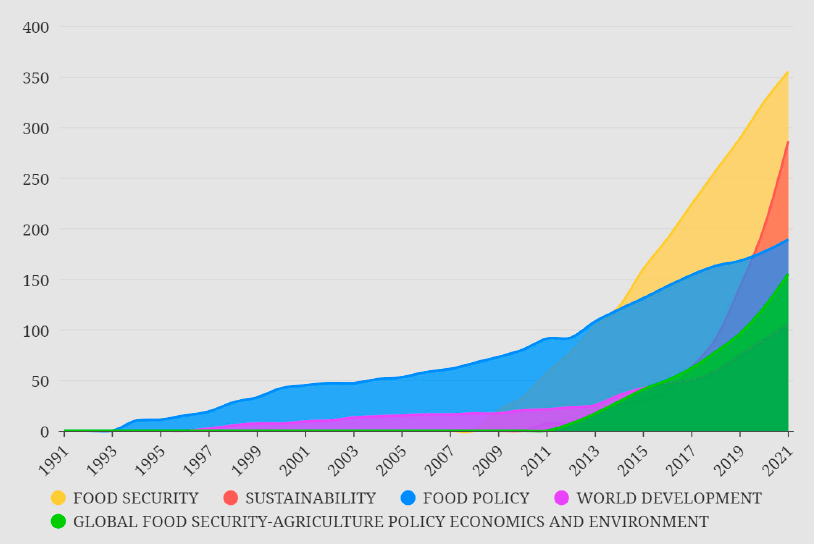
Figure 4. Popular journals in the field of food security from 1991 to 2021.